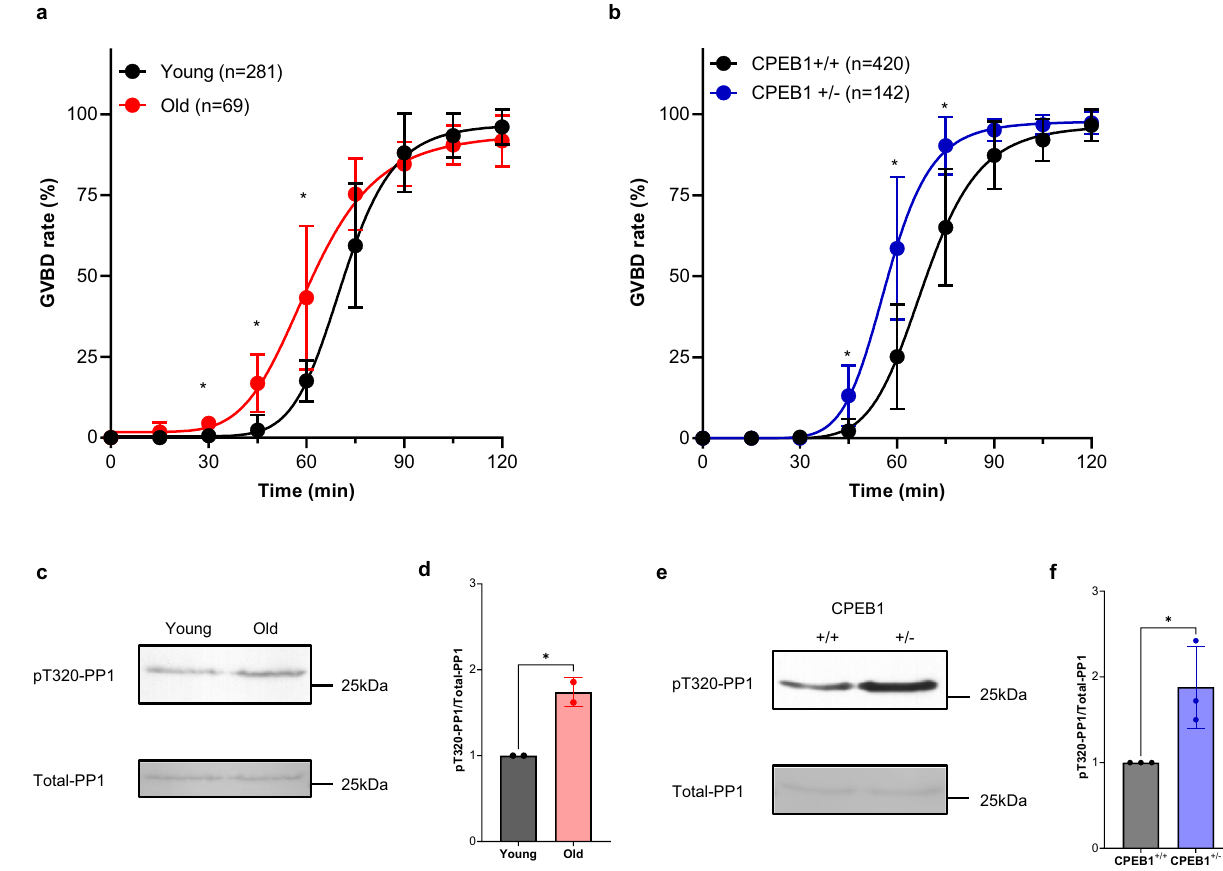
Fig. 6 | Decreased CPEB1 expression accelerates meiosis reentry. a , b GV oocytes from young and old mice ( a ), or GV oocytes from Cpeb1 +/+ ;Zp3Cre mice (CPEB1 +/+ oocytes) and Cpeb1 fl /+ ;Zp3Cre mice(CPEB1 +/ − oocytes) ( b ) wereincubated with cilostamide-free medium and bright fi eld images were captured every 15min. ThecumulativeGVBDtimeswereplotted.Experimentswererepeatedatleastthree times, and the data are shown as the mean ± SD. Two-tailed multiple unpaired Student ’ s t tests were used to evaluate statistical signi fi cance at each time point. a P =0.00032for30min, P =0.0076for45min, P =0.016for60min. b P =0.0036 for 45min, P =0.0051 for 60min, P =0.019 for 75min. c – f CDK1 activity were measured using Kinase assays. Young and old GV oocytes ( c , d ), or CPEB1 +/+ and CPEB1 +/ − GVoocytes( e , f )wereincubatedwithcilostamide-freemediumfor45min.